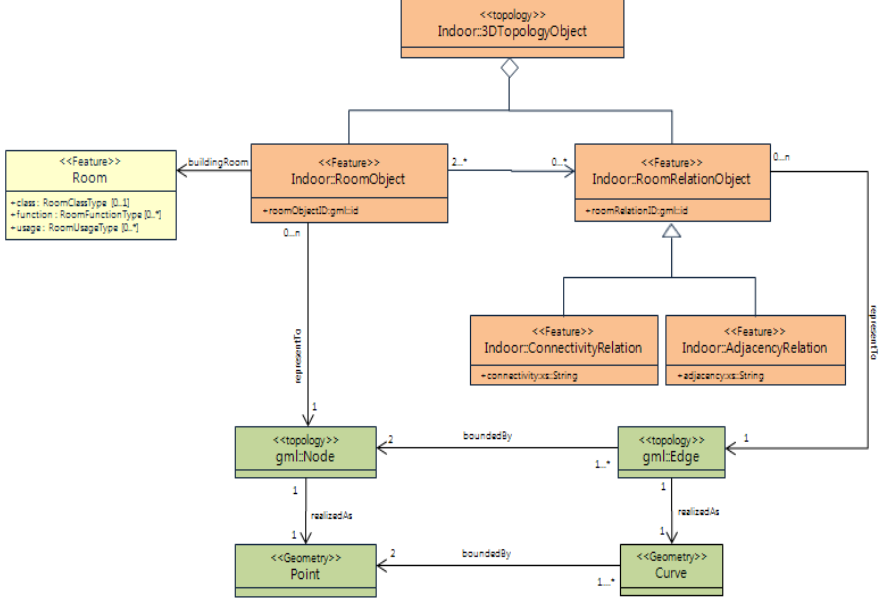
Figure 7. 3D Object Topology Model, CityGML Indoor